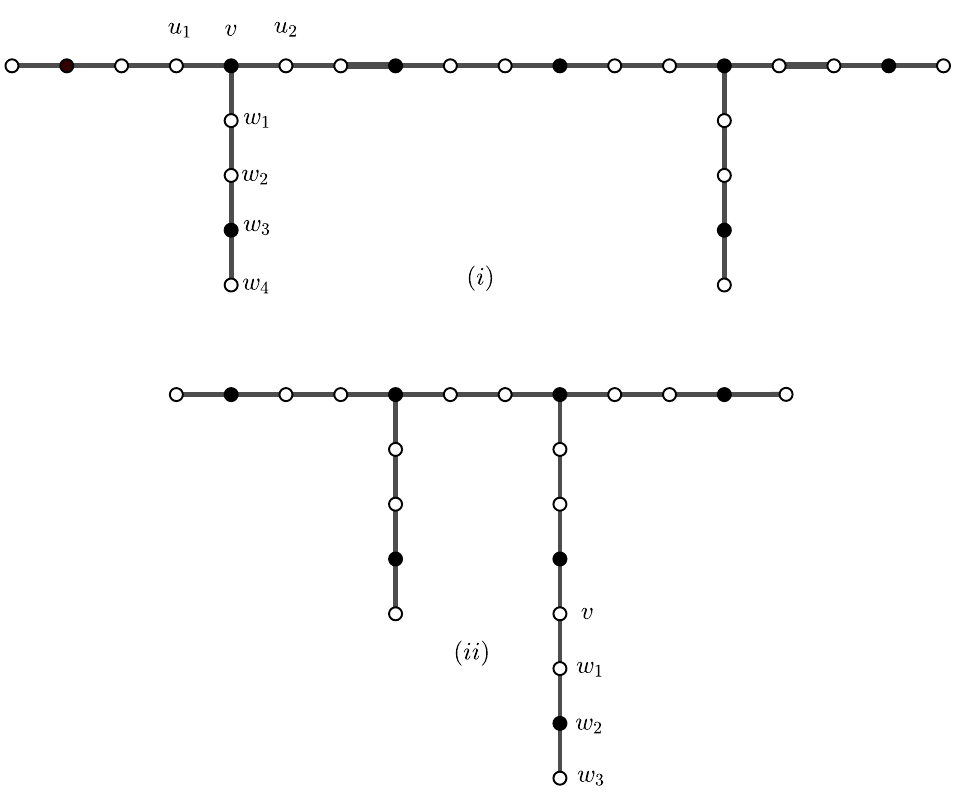
Figure 2: Two examples in graph family H